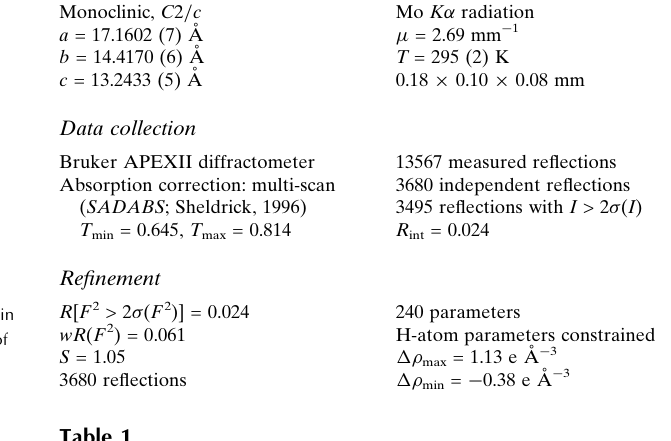
Bruker APEXII diffractometer Absorption correction: multi-scan